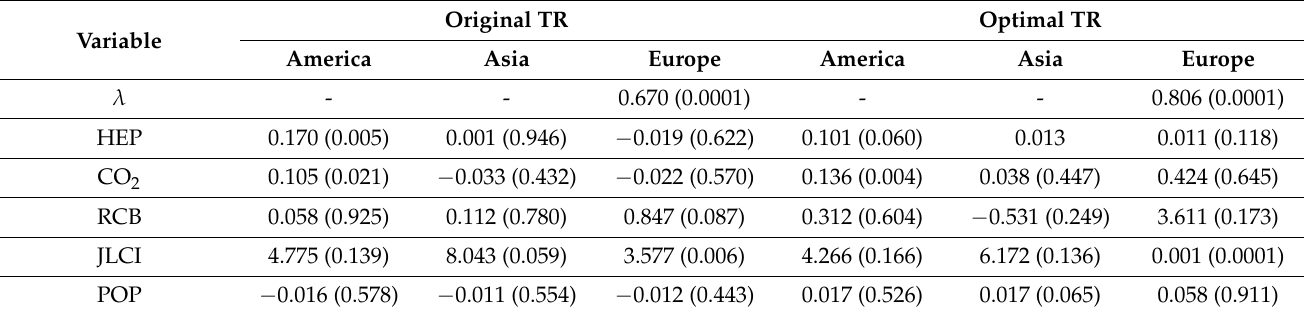
Table 7. Estimation results for transition readiness (new and optimised) for different